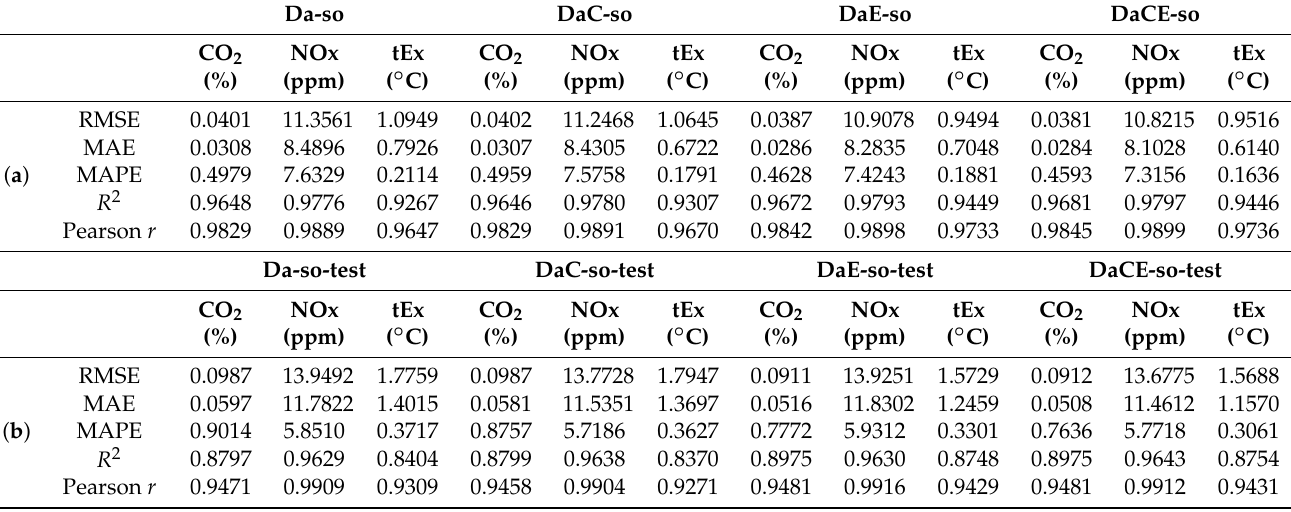
Table 11. Metrics from different datasets for the SVM model with the SCR mode: ( a ) training from ATC training set and the value of metrics from the validation set; ( b ) trained model tested from BTC and its value of